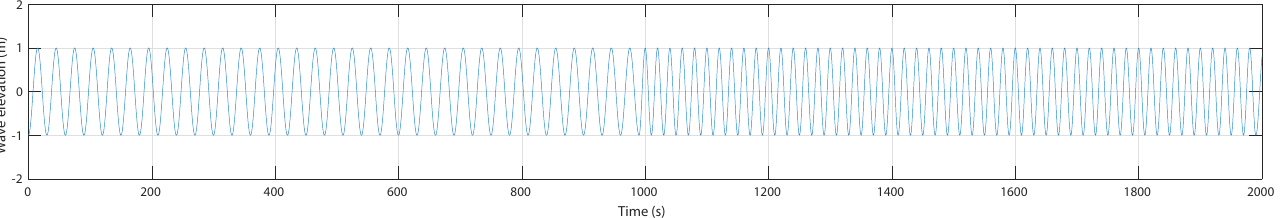
Figure 6. Considered wave input with two different wave periods.